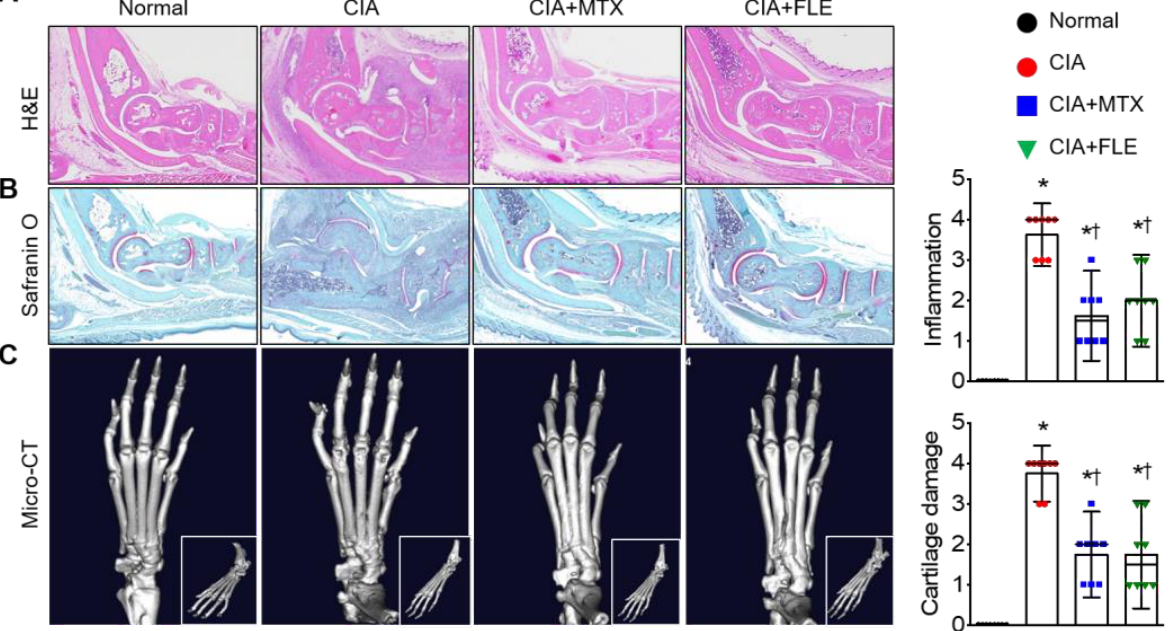
Figure 2. FLE alleviated synovial inflammation and joint destruction. Pathological features in mouse ankle joints were assessed. Representative photomicrographs of ankle joints stained with H&E ( A ) and safranin O ( B ). ( C ) Representative micro-CT images of ankle joints. Data are shown as means ± SE ( n = 8). * p < 0.05, compared to Normal. † p < 0.05, compared to CIA. The block dot, red dot, blue square, and green triangle means the